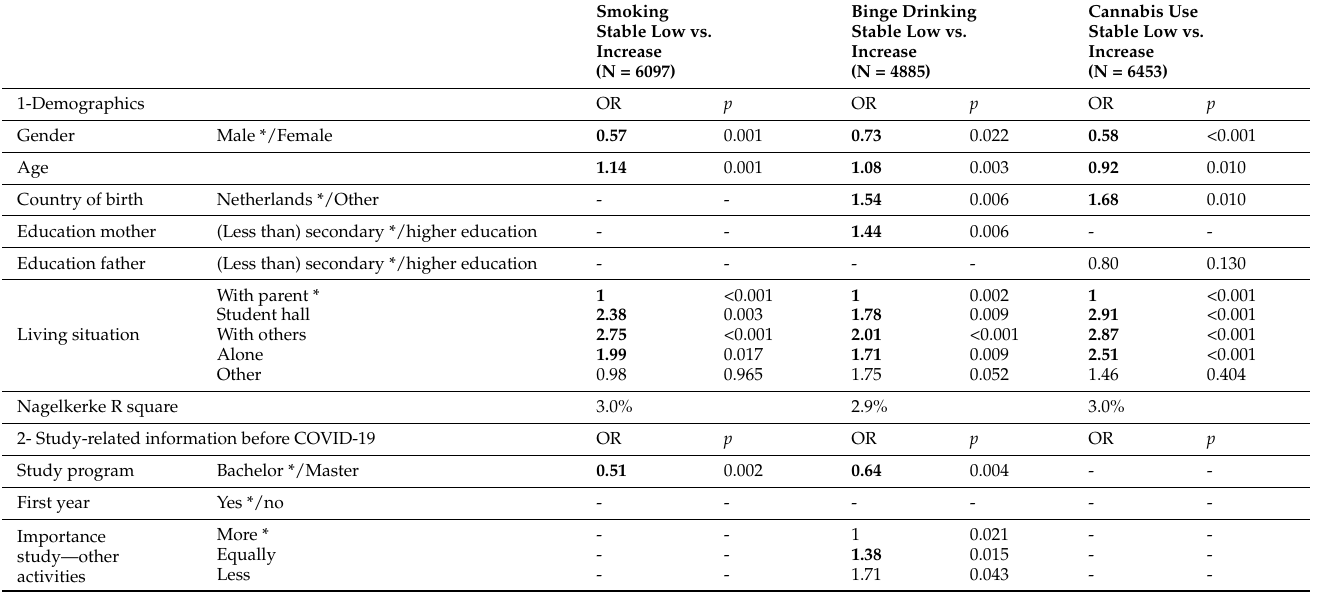
Table 5. Trends in substance use during the first COVID-19 lockdown in non-users before COVID-19: stable low vs. increase (Model B) #